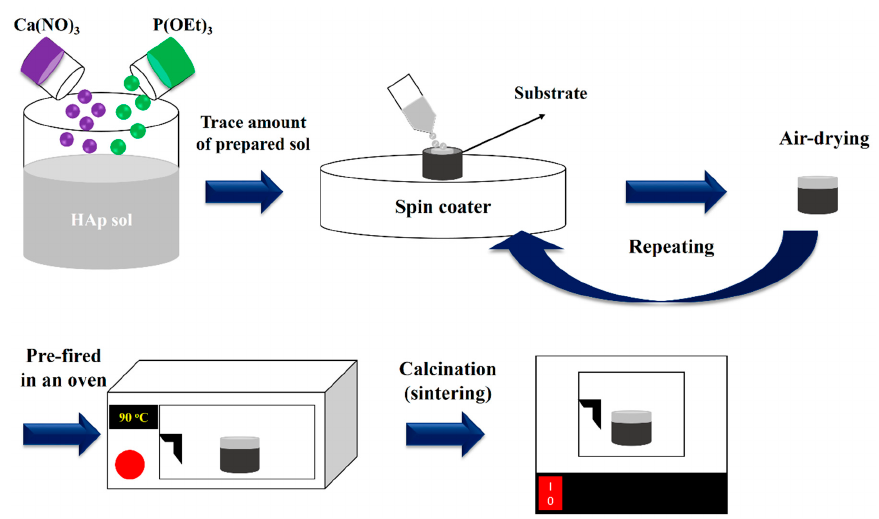
Figure 4. Schematic illustration of the spin-coating process for fabrication of HAp coating.